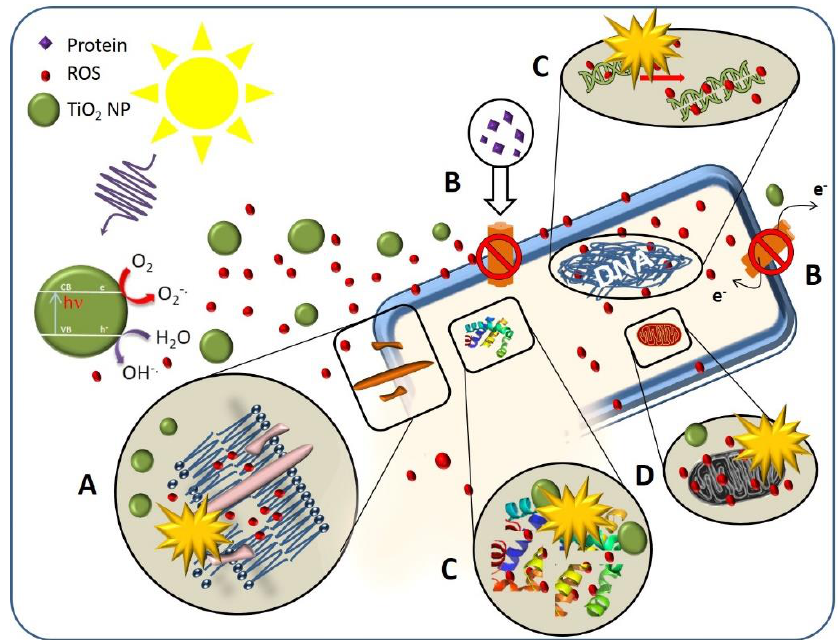
Figure 5. Schematic diagram of TiO 2 NPs toxicity mechanism on the cellular components of the pathogen microorganisms: ( A ) cell wall, ( B ) cytoplasmic flow, ( C ) macromolecular, ( D ) organelles.